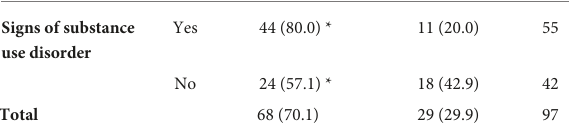
TABLE 7 Interrogation outcomes as a function of suspects’ substance use disorder status in Study 2 ( N =